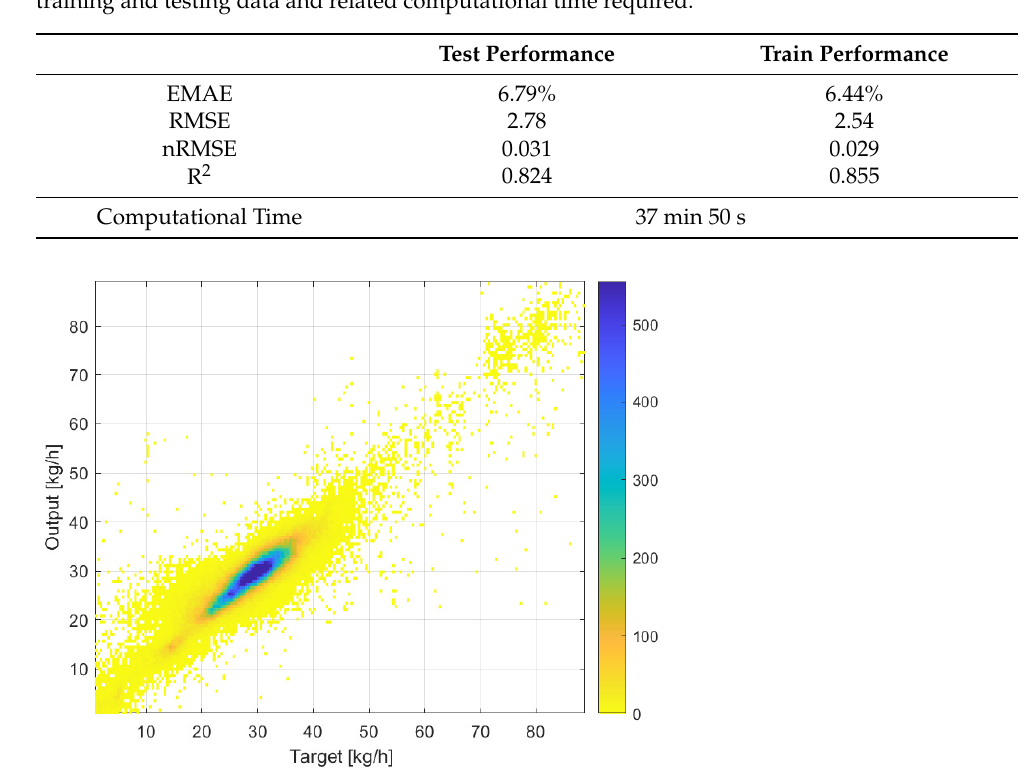
Table 4. Model performance for prediction of the SO 2 flow rate: values of the errors evaluated on the training and testing data and related computational time required.